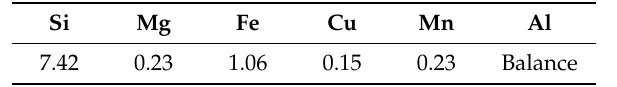
Table 1. Aluminum AlSi 7 Fe 1 casting alloy chemical composition (wt %).